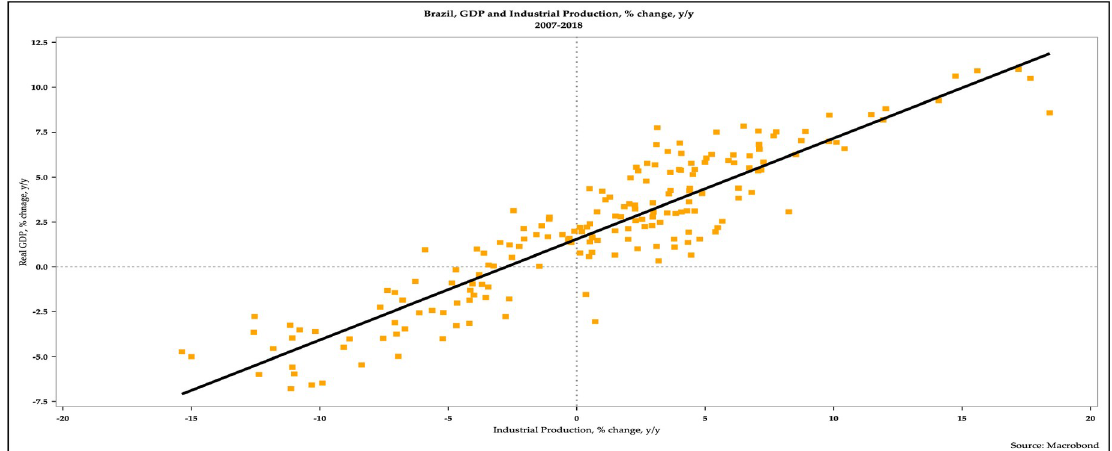
Fig 4. Scatterplot of real GDP growth and industrial production growth in Brazil, 2007–2018.